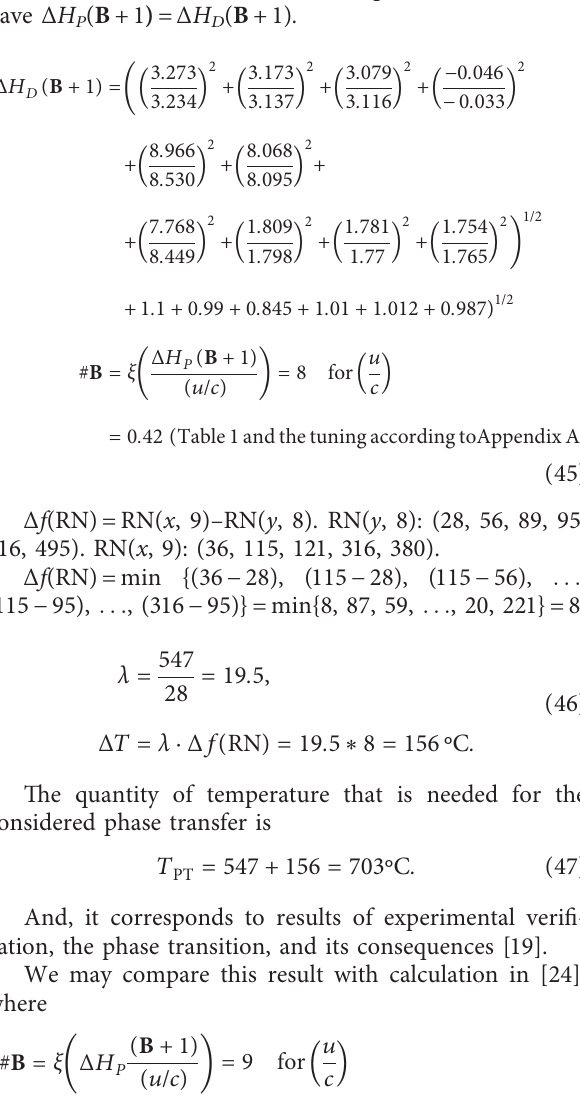
Figure 3: Matroid M � 〈 X , MB 〉 , # X � 14, with a marked base B , # B � 5 and with extension of this base by one